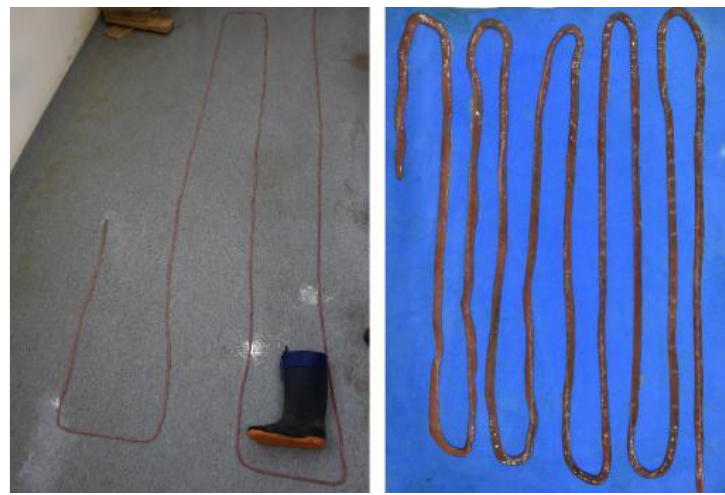
Figure 17. Two views of the extended jejunum after removing the mesojejunum. Note its great length.